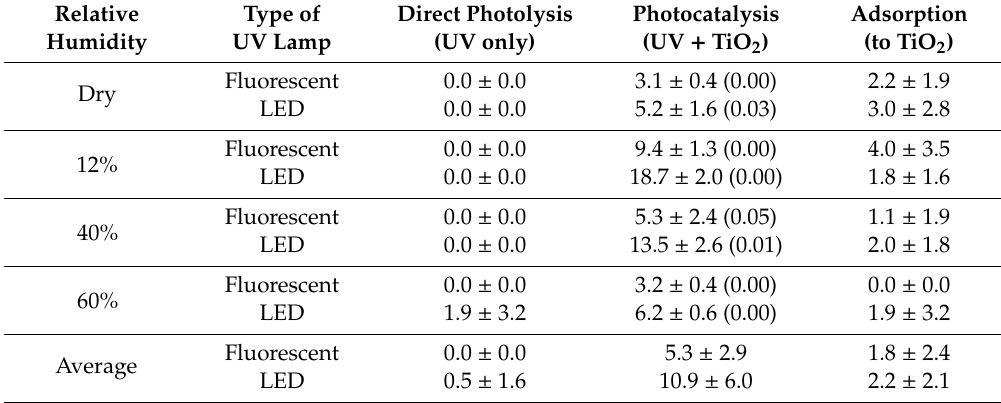
Table A2. NH 3 mitigation under di ff erent light types and relative humidity at a treatment time of 200 s. Values in the table report % reduction ± standard deviation ( p -value). Bold font signifies statistical significance.